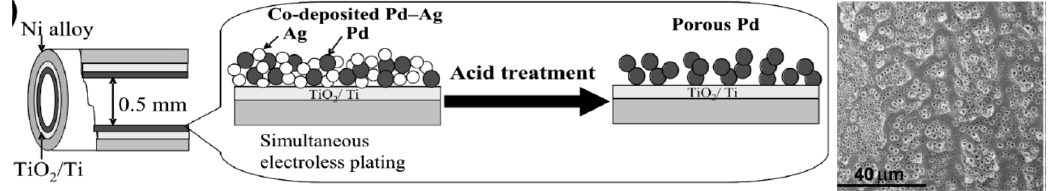
Figure 13. The scheme of Ag-Pd co-plating ( a ) and sequential removal of Ag to obtain porous Pd layer ( b ). (Reprinted from [15]).